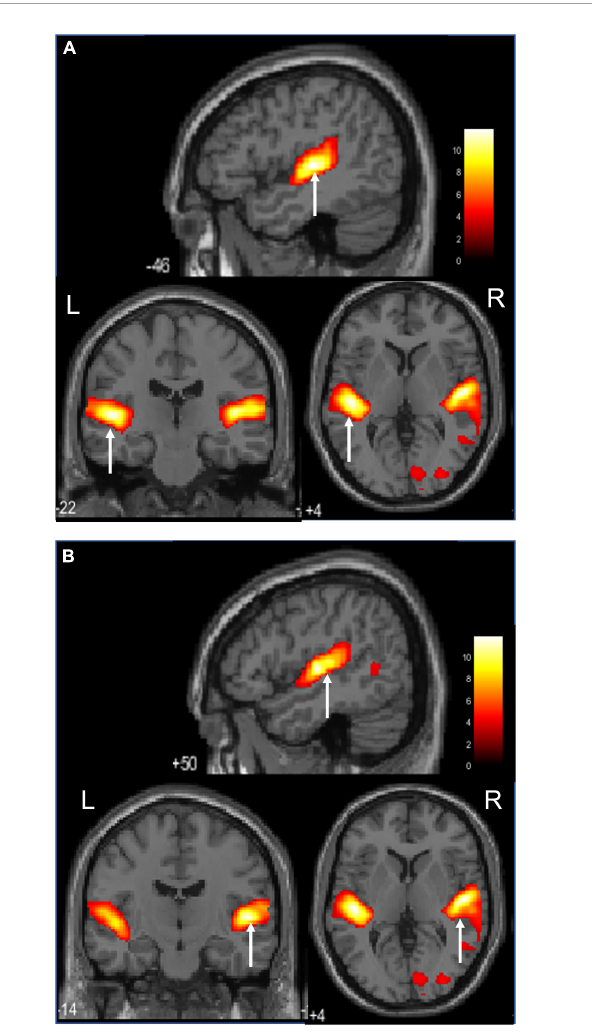
FIGURE4 Activation during the ASMR audiovisual stimulation task (Sagittal, coronal, and axial images.). (A) Activation of the left insula cortices is confirmed. (B) Activation of the right insula cortices is confirmed.